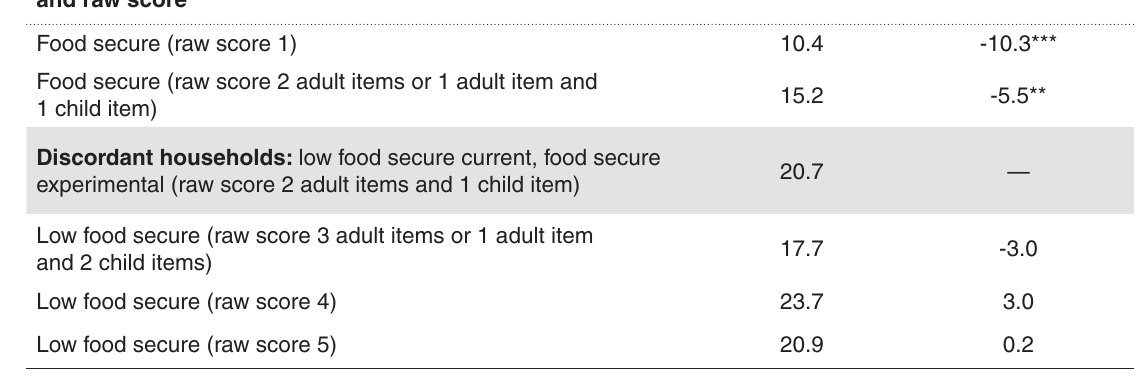
Percent of households with children and income less than 185 percent of the Federal poverty line that used a food pantry, by food security status, 2008-15 Panel A: household food security status on current and experimental classification methods and raw score